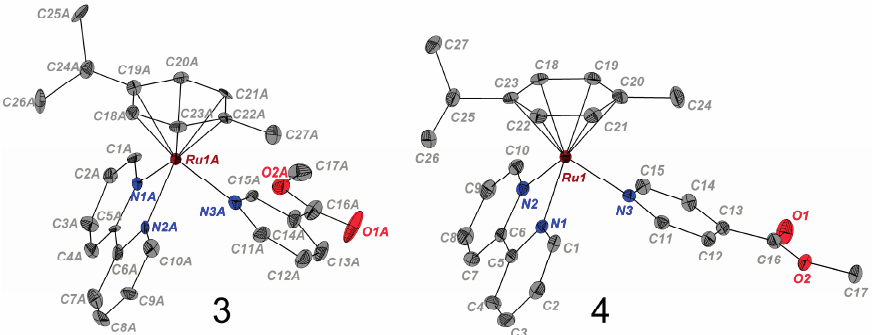
Figure 2. X-ray structures present in the asymmetric unit of cations [( η 6 - p -cym)Ru(bpy) ( m -COOCH 3 -Py)] 2+ ( 3 , left) and [( η 6 - p -cym)Ru(bpy)( p -COOCH 3 -Py)] 2+ ( 4 , right). One